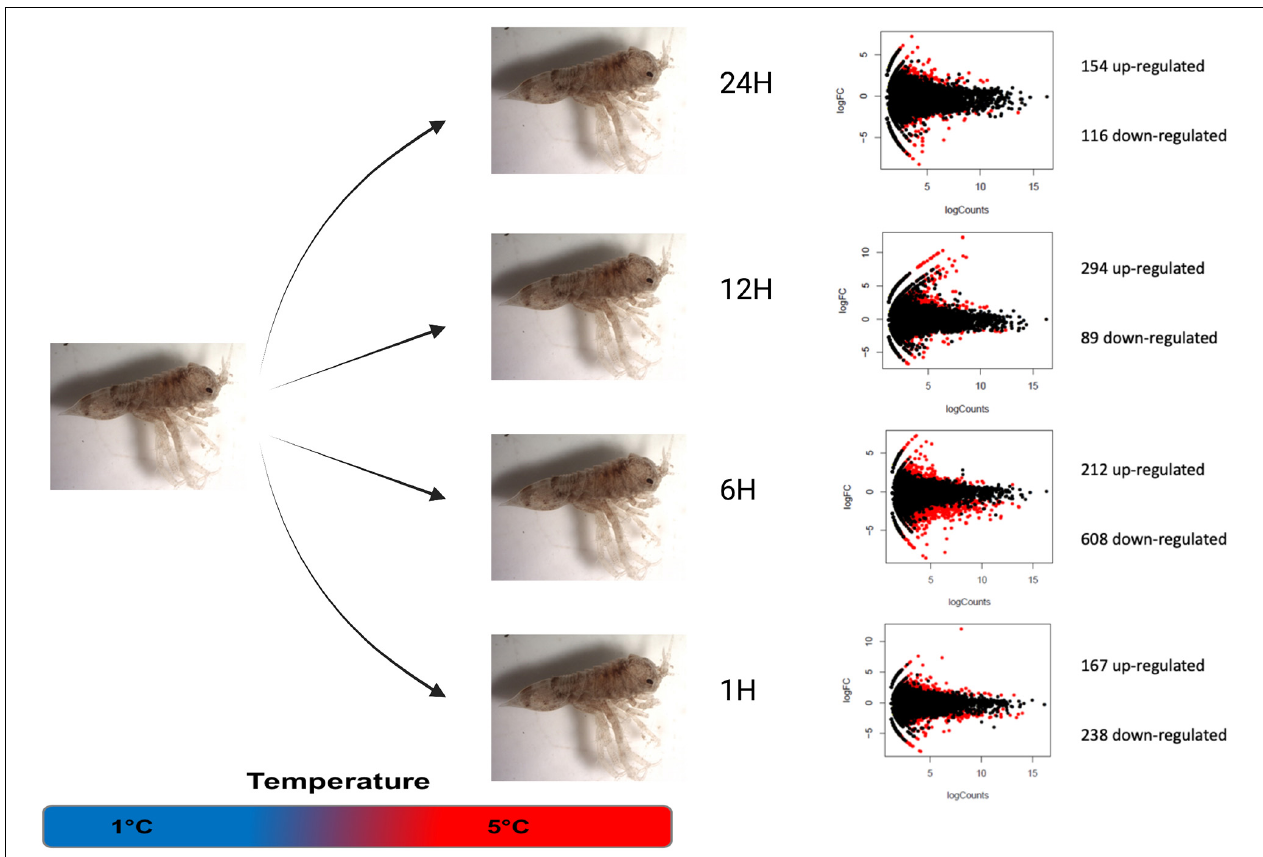
FIGURE 1 | Differentially expressed transcripts between control (1 ◦ C) and treatment (5 ◦ C) conditions during different kinetic times. Volcano plots showing the up- and down-regulated genes between heat stress and control condition at each time point. Genes which were found to be significantly different by edgeR are indicated in